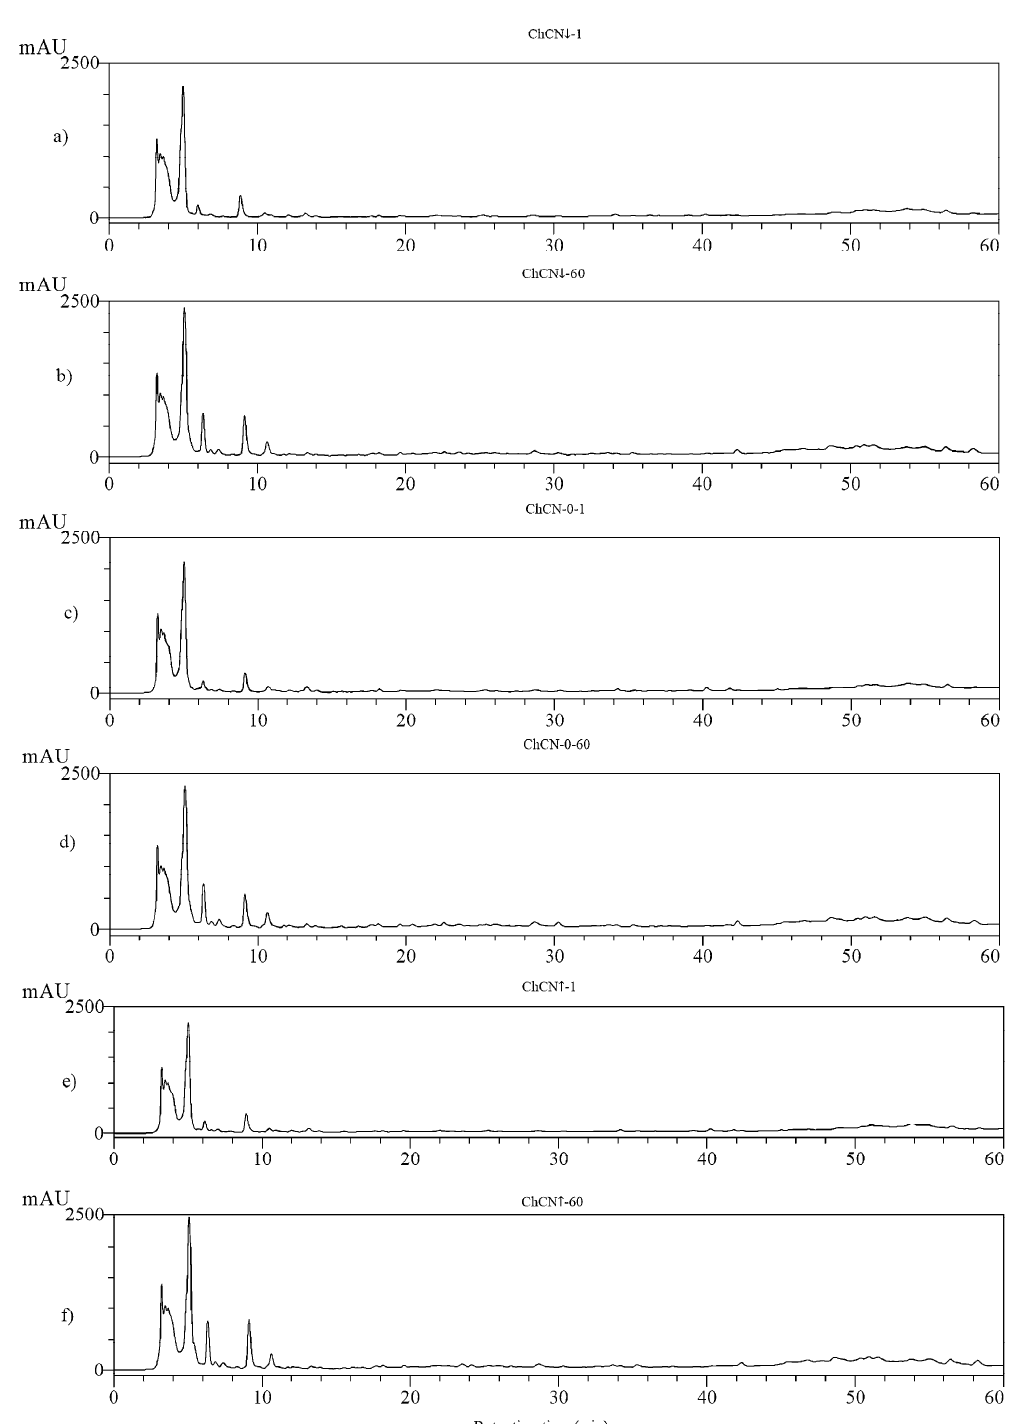
Figure 1. RP-HPLC chromatograms of water-soluble extracts derived from Gouda cheese with modified β -casein content before and after ripening (1 and 60 days, respectively). Abbreviations: ChCN ↓ -1 ( a ), ChCN ↓ -60 ( b ), ChCN-0-1 ( c ), ChCN-0-60 ( d ), ChCN ↑ -1 ( e ), ChCN ↑ -60 ( f )—water-soluble extracts derived from Gouda cheese with: reduced ( ↓ ), normative (0), and increased ( ↑ ) content of β -casein after 1 (suffix 1) and 60 (suffix 60) days of ripening, respectively (see Methods).